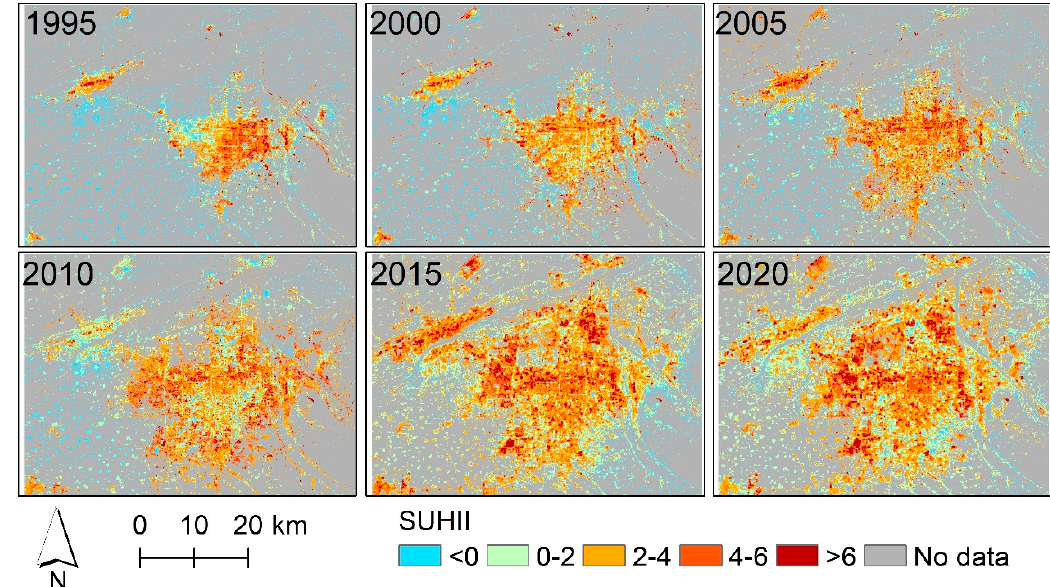
Figure 5. Spatial pattern of SUHII (°C) in the study area for six time periods from 1995 to 2020.